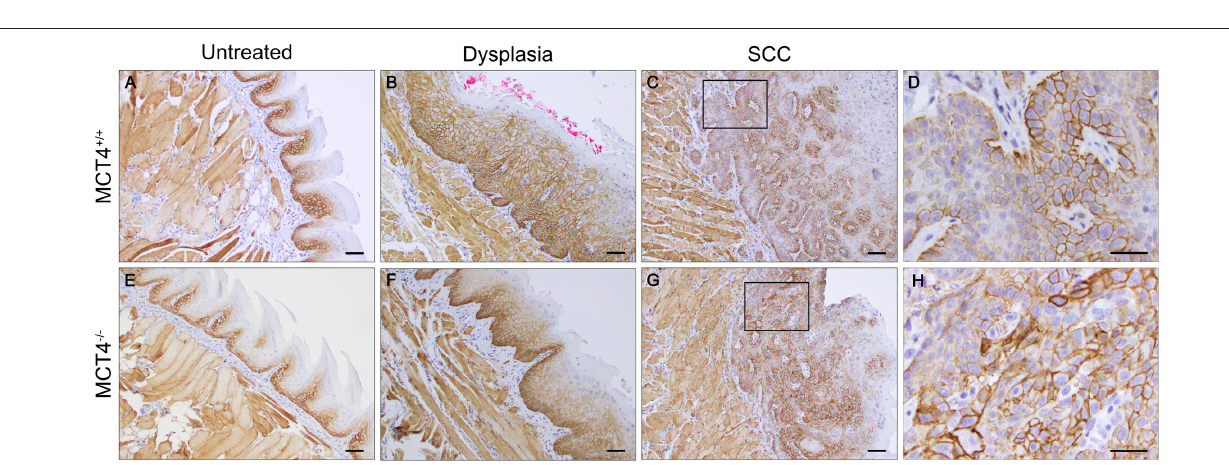
FIGURE 5 | MCT1 expression is altered in 4NQO treated wild type and MCT4 − / − animals. IHC staining of paraffin sections of tongues from untreated and 23 weeks 4NQO treated wild type and MCT4 − / − mice. MCT1 expression in normal tongue tissue is restricted to the basal cell layer of the epithelium in both wild type and MCT4 − / − mice (A , E) . After 4NQO treatment, MCT1 extends into the suprabasal region of dysplastic lesions (B,F) , and is irregularly expressed in areas at the leading edge of invasive cancer (C,D,G,H) . Scale bar: 50 µ m or 20 µ m (D,H)